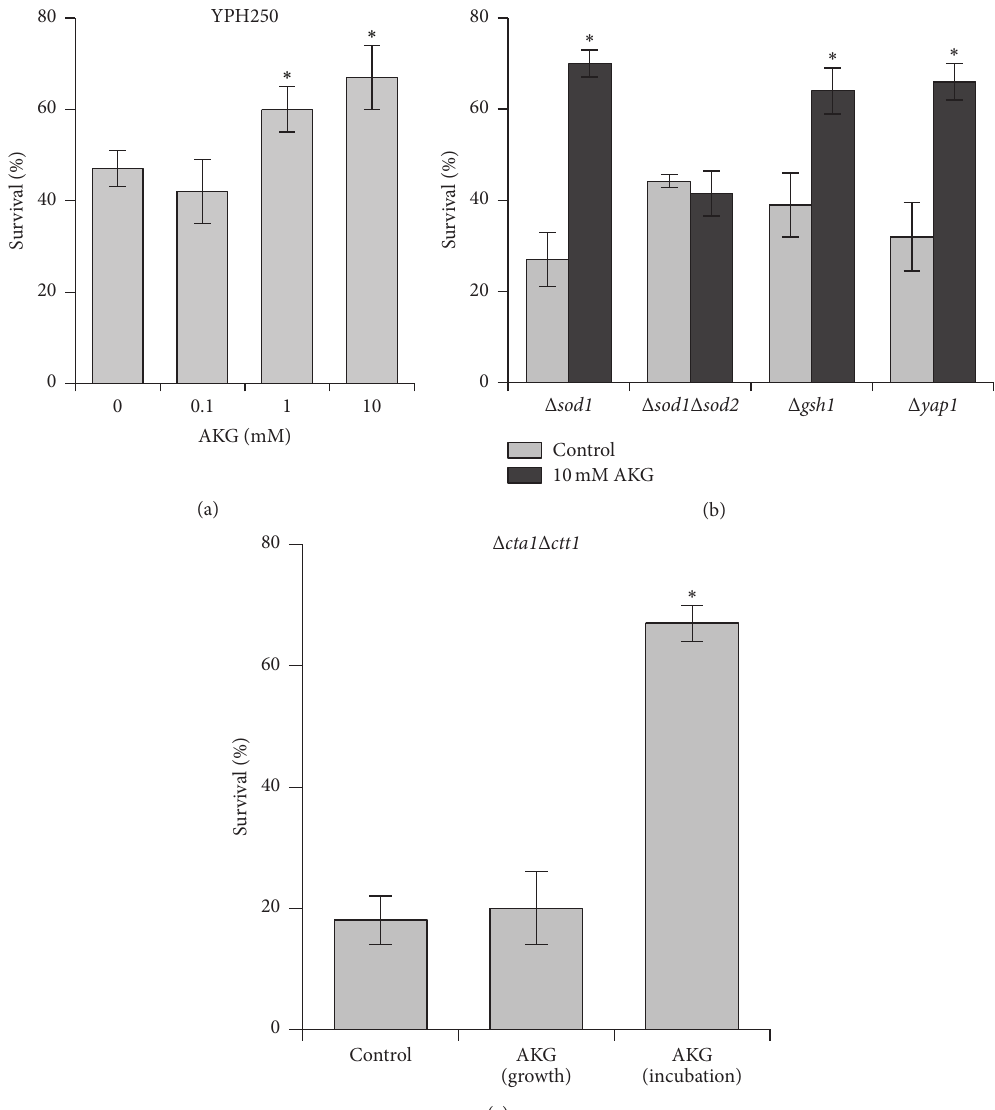
Figure 2: Effect of exposure to 10mM H 2 O 2 for 30 min on cell survival in S. cerevisiae YPH250 strain and its isogenic derivatives grown in the absence or presence of 10mM AKG. (a) YPH250 cells (wild type) grown with AKG different concentrations; (b) mutant cells grown without or with 10 mM AKG; (c) Δ cta1 Δ ctt1 cells grown without or with AKG and were treated with only 10mM H 2 O 2 denoted as “control” and “AKG (growth),” respectively; “AKG (incubation),” Δ cta1 Δ ctt1 cells grown without AKG were treated with 10 mM H 2 O 2 in combination with 10mM AKG. Data are means ± SEM, 𝑛 = 5 - 6 . ∗ Significantly different from respective control values with 𝑃 < 0.05 using Dunnett’s test (a) or Student’s t -test (b,